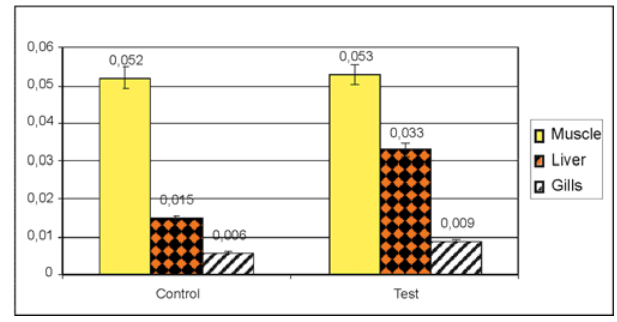
Fig. 5. Copper concentration (mg/kg) in tissues of rainbow trout